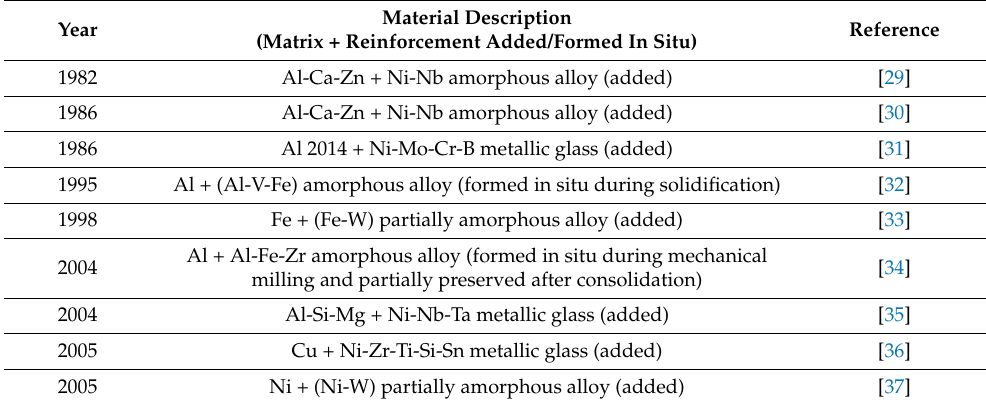
Table 1. Early studies on metallic glass (amorphous alloy)-reinforced metal matrix composites (MMCs).